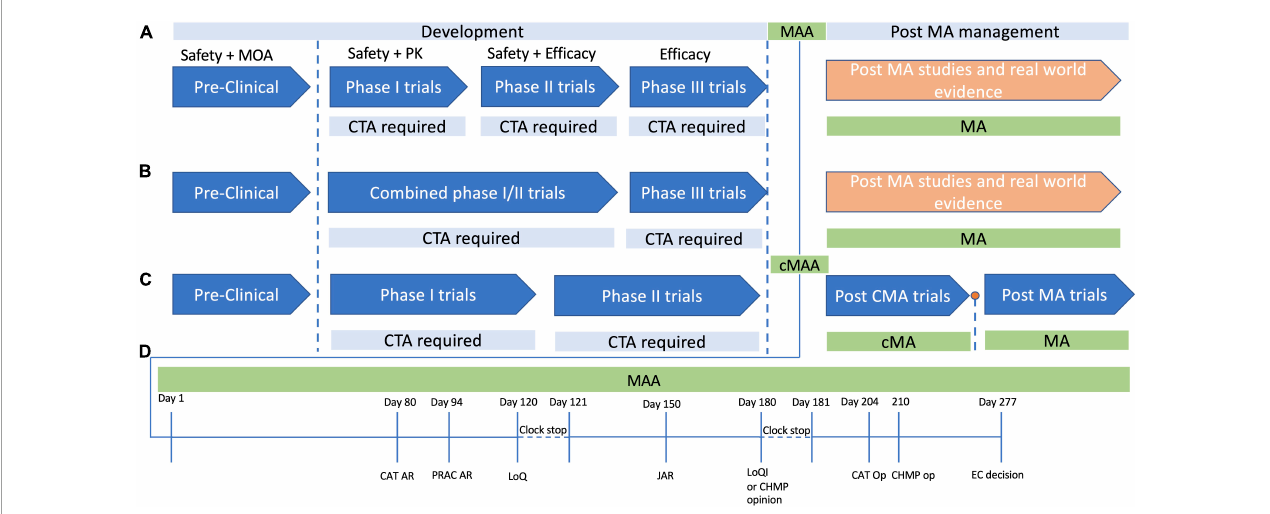
FIGURE1 Development and approval pathways for advanced therapy medicinal products (ATMPs) in Europe. The development cycle of products for human use has a number of steps which ensure the safety, efficacy and quality of the product in question. (A) In typical product development cycle, pre-clinical research is followed by first-in-human or Phase 1 clinical trials, with Phase 2 assessing safety and early efficacy, and Phase 3 providing confirmation of efficacy. In each case a clinical trial application (CTA) is required before each phase. (B) It is often not possible to perform healthy volunteer trials with ATMPs for various ethical reasons, and as such there may be combined phase 1/2 trials in which safety and efficacy are tested simultaneously. Phase three studies then provide data to support a marketing authorization application (MAA), and if marketing authorization (MA) is granted, then post MA trials are usually performed to confirm efficacy and safety further, with continued MA often dependent on follow up data. (C) A conditional MA (cMA) approval process exists where there is an unmet clinical need and a belief that the ATMP may provide benefit to the patient cohort even in the absence of comprehensive data. A cMA may be granted, in advance of Phase 3 trials, and following convincing data a full standard MA may be approved, or MA may be withdrawn if there is not convincing evidence to support the products approval. (D) The MAA review process typically takes place over a timeline of 277 days committee for advanced therapies. At day 80 and day 94 the committee for advanced (CAT) and the pharmacovigilance risk assessment committee (PRAC) generate their assessment reports, which are then consolidated with the committee for medicinal products for human use (CHMP) assessment points into list of questions (LoQ). The assessment clock then stops and the submitter has 90 days to respond to the LoQ. After the 90 days, or whenever the applicant submits their responses, the CAT, CHMP, and PRAC generate a joint assessment report (JAR), which is then sent to the applicant to view, and is formalized at day 180. At this stage if all issues from the LoQ are addressed, they may produce a draft opinion, or otherwise they will present the applicant with a list of outstanding issues (Looi). The then have another 90 days clock stop to address any remaining issues,